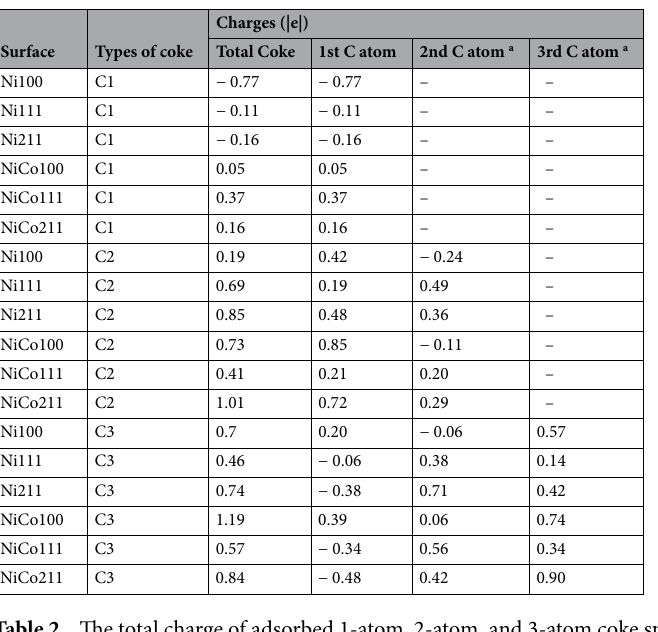
Table 2. The total charge of adsorbed 1-atom, 2-atom, and 3-atom coke species, and their individual C atom charge within the coke species all in the unit of electron. a The charges of the 2nd C atom are shown for C2 and C3 since C1 represents atomic coke consisting of 1 atom, while the charge of the 3rd C atom is shown for the C3 system only.